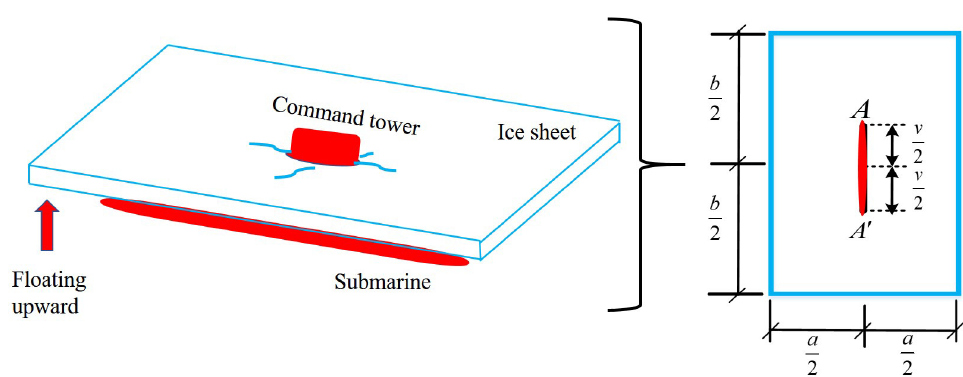
Figure 3. Calculation model of ice breaking force of